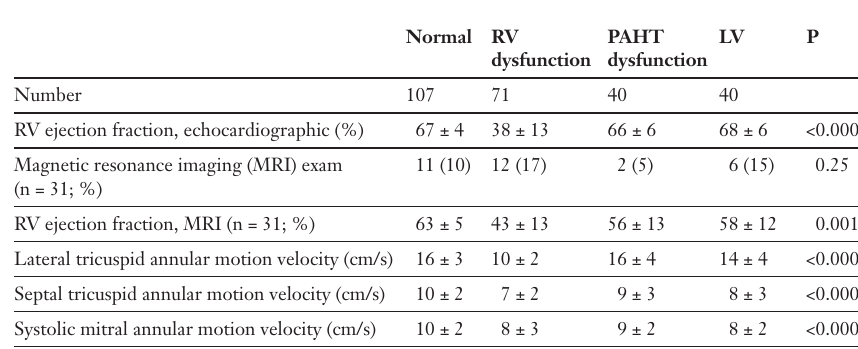
Correlation in all study patients be- tween systolic lateral tricuspid annular ve- locity (TV lat , horizon- tal axis) as obtained by pulsed wave tis- sue Doppler imaging, and right ventricular ejection fraction as determined by two-dimensional echocardiography (vertical axis). The thick lines mark the thresholds of 12 cm/s TV lat and 55% RV ejection